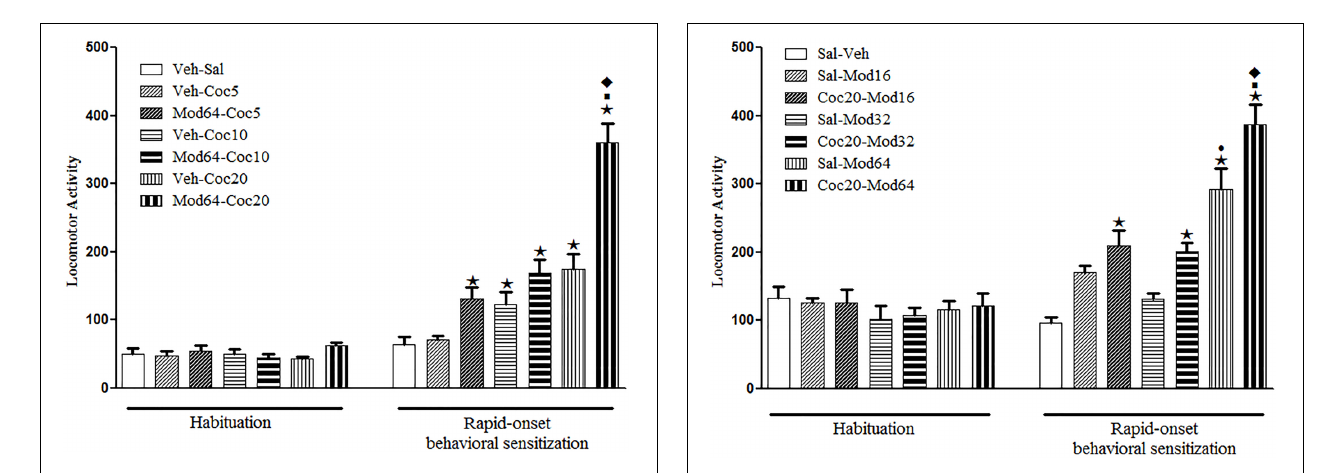
FIGURE 4 | Locomotor activity during the 3rd day of habituation and during the challenge session of the rapid-onset behavioral sensitization test with saline or different doses of cocaine. The animals received a priming injection of modafinil vehicle solution (Veh-) or 64 mg/kg modafinil (Mod64-), and after 4 h, a challenge injection of saline (-Sal), 5 mg/kg (-Coc5), 10 mg/kg (Coc10), or 20 mg/kg (-Coc20) cocaine. After 5 min, the locomotor activity was measured for 10 min in the open field. Data are reported as mean ± SEM ( n = 12). (cid:70) P < 0.05 compared with the Veh-Sal group. (cid:4) P < 0.05 compared with the respective control group that received a priming injection of vehicle solution. (cid:117) P < 0.05 compared with all of the other groups.